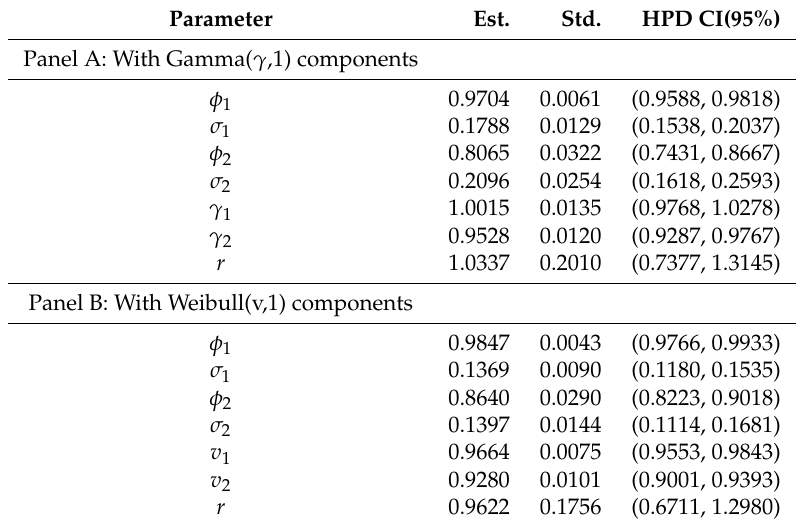
Table 2. Parameter estimates based on TSCD models based on the IBM transaction data.